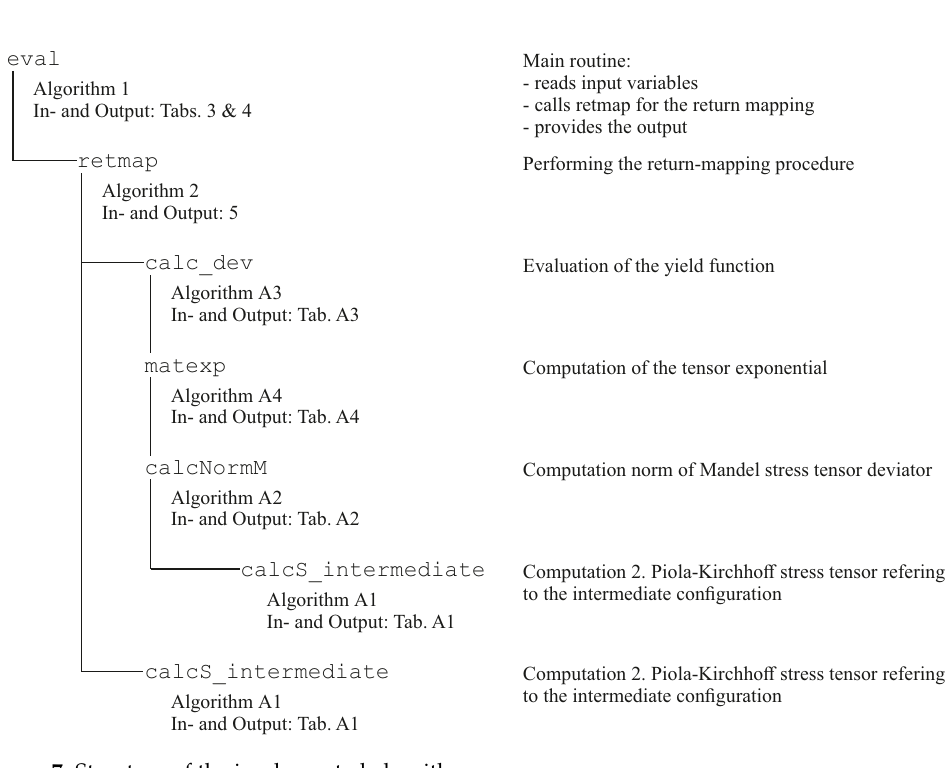
Figure 7. Structure of the implemented algorithm.